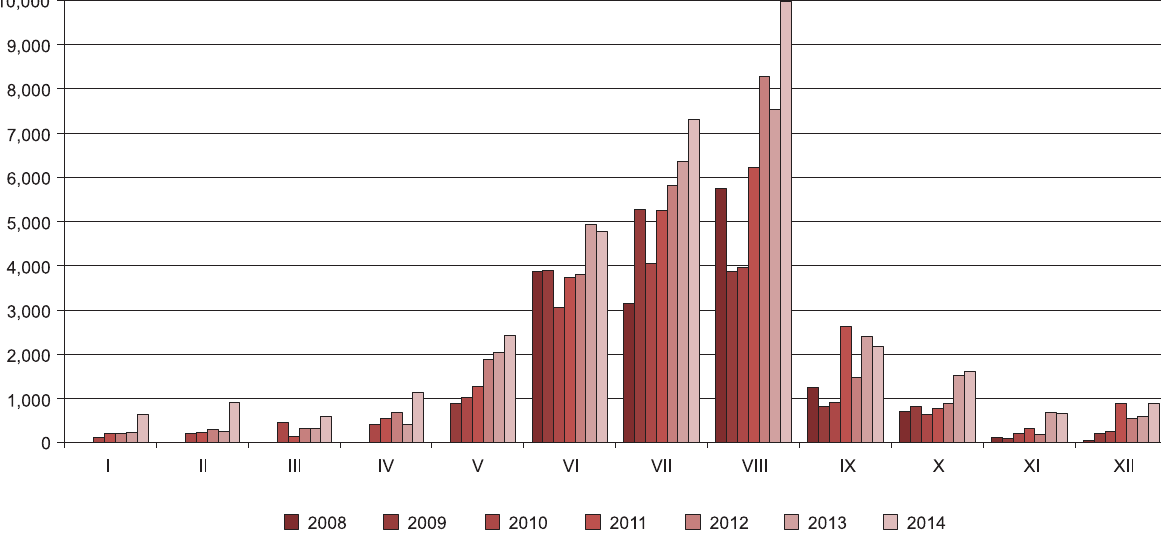
Fig. 12. Seasonal character of tourism on the Orava Forest Railway (the number of tourists). Source: own elaboration based on data from the Kysuce